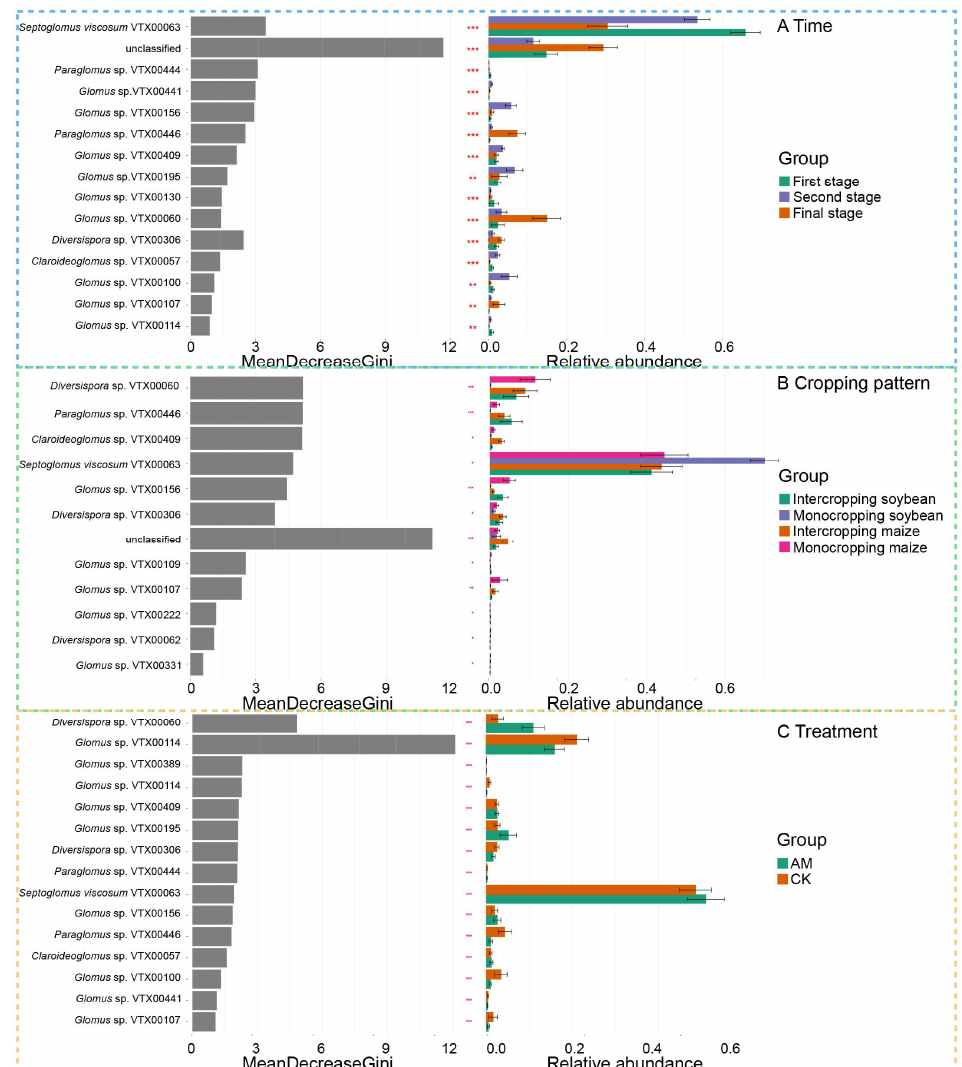
Figure 4. Random forest analysis showing bias distribution of the relative abundance of AMF taxa. ( A ) distribution in different growth stages, ( B ) distribution in different cropping patterns, ( C ) distribution in different inoculation treatments. *: p < 0.05, **: p < 0.01, ***: p < 0.001.